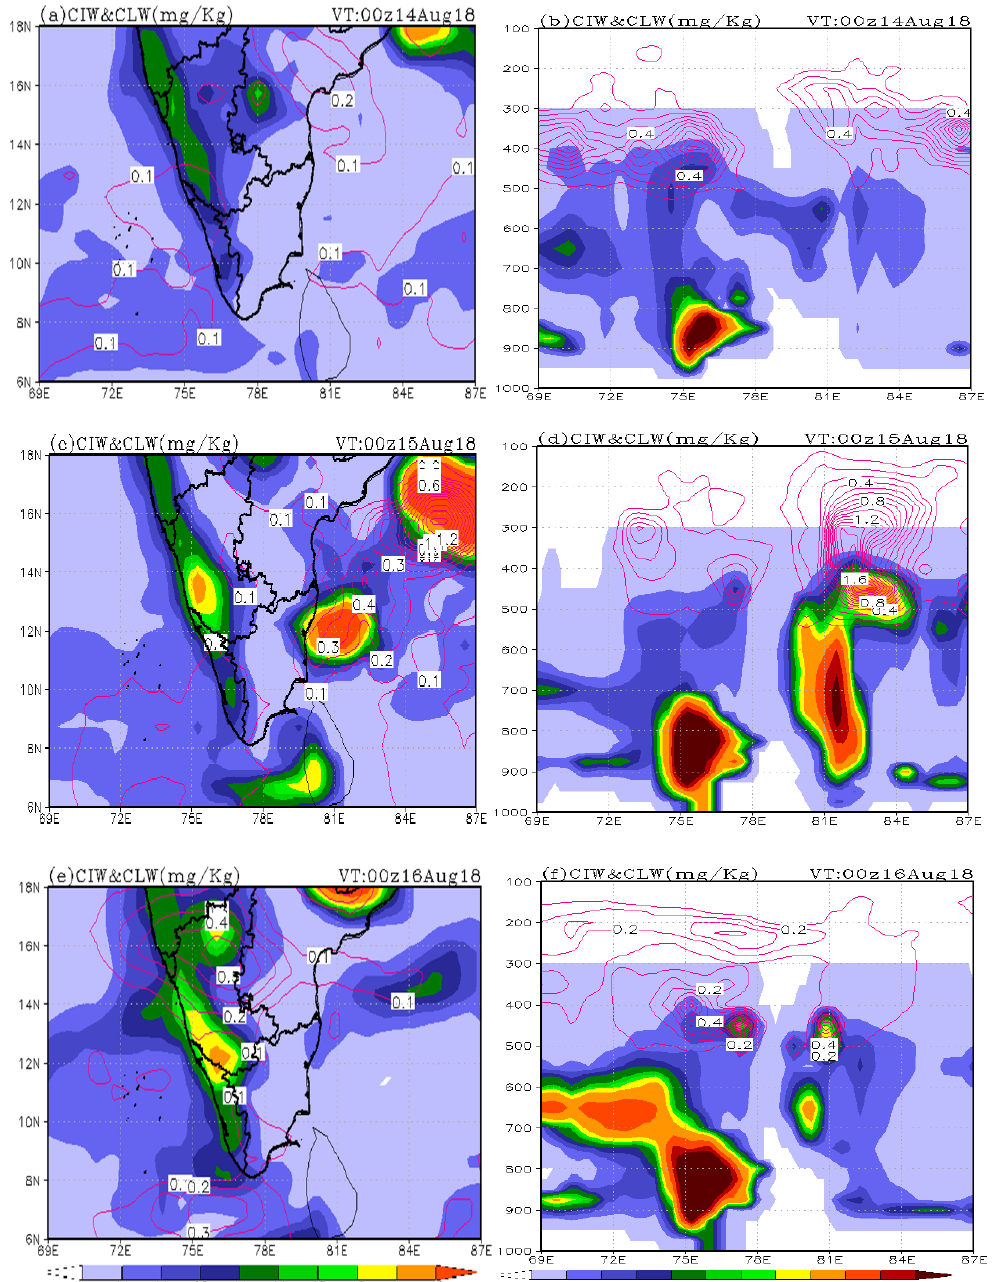
Figure 9. The cloud liquid water content (shaded) and cloud ice water content (contour) horizontal ( a ) and vertical-cross section ( b ) valid at 00 UTC on 14 August 2018. Both ( c – d ) and ( e – f ) are the same as ( a – b ), but are valid for 00 UTC 15–16 on August 2018 derived from ERA-Interim reanalysis at 25 km resolutions.